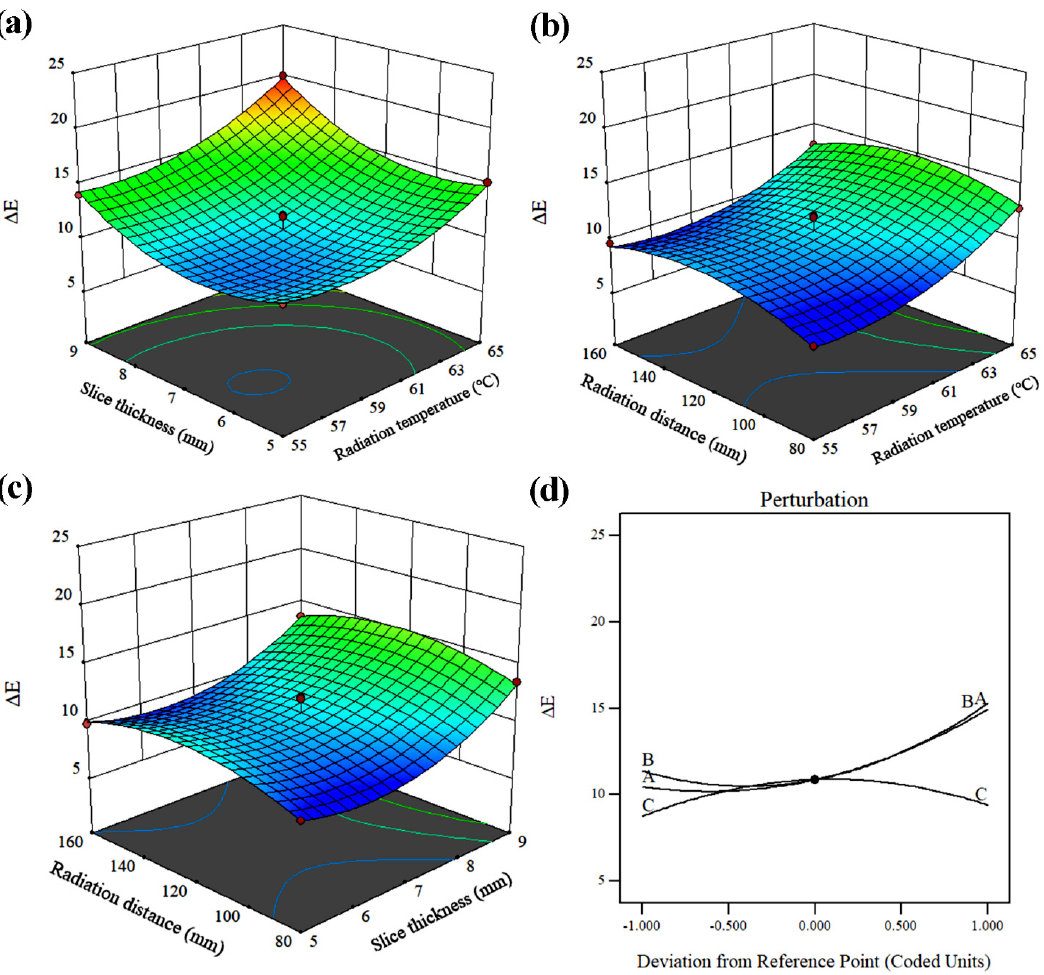
Figure 5. Response surface ( a – c ) and perturbation plot ( d ) for the effects of variables on the ∆𝐸 of cantaloupe slices.